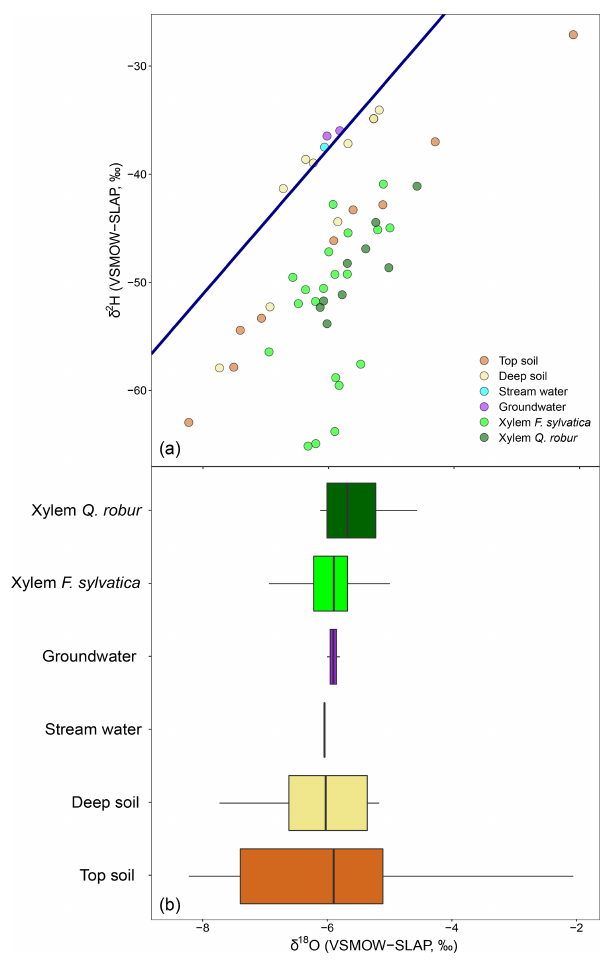
Figure 8. Differences in the isotopic composition of xylem water and its potential sources using one isotope. The top panel depicts the dual-isotope plot for a single date (4 July), with xylem water and sources. The bottom panel is the box plot of the δ 18 O values for xylem water of F. sylvatica and Q. robur and each of the potential sources. Box size represents the interquartile range, the black line is the median, the whiskers indicate variability outside the upper and lower quartiles, and individual points are